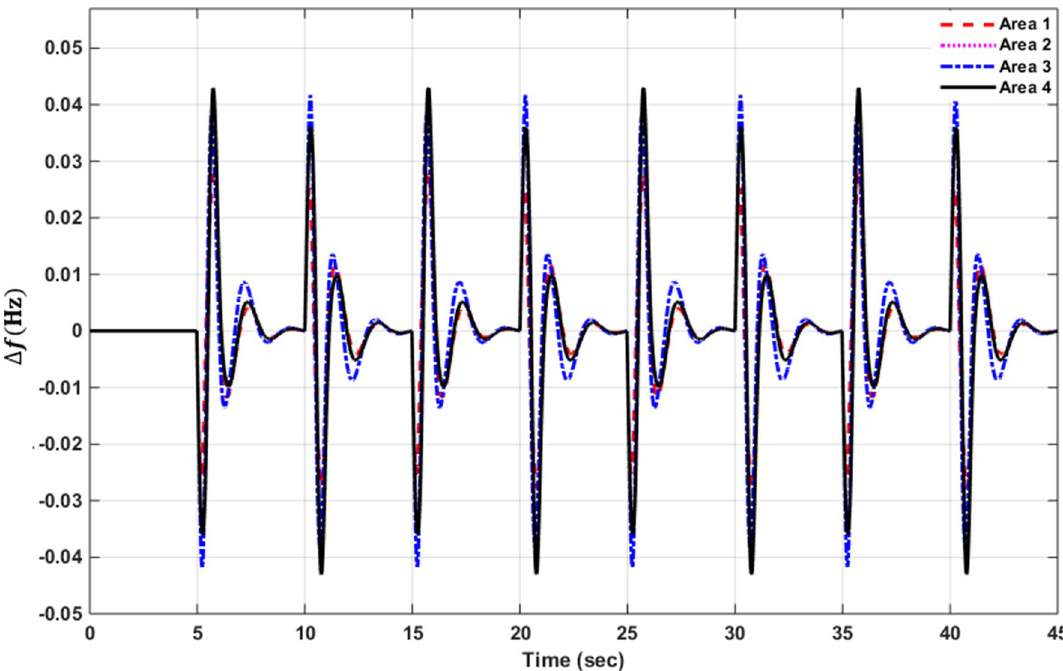
Figure 8. Frequency deviations of OQAGC for four areas with load